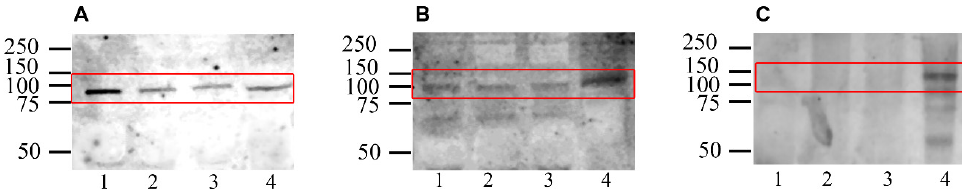
Figure 1. Western blot analysis of the presence of nitric oxide synthase isoforms eNOS ( A ), nNOS ( B ) and iNOS ( C ) in swim-up selected (lane 1) and in vitro capacitated without (control, lane 2) or with cAMP-elevating agents (Cap-C, lane 3) ram sperm protein extracts. Positive controls: rat lung extract (RLE, lane 4 in A) for eNOS, mouse brain extract (MBE, lane 4 in B) for nNOS and mouse macrophage activated with IFN ɣ /LPS lysate (LPS-L, lane 4 in C) for iNOS. Immunofluorescence analysis revealed the presence of the three isoforms in ram spermatozoa. Two different immunotypes for each isoform were distinguished. Immunotype 1 with labeling at the postacrosomal region, neck and apical edge, and immunotype 2 with labeled postacrosomal region and neck, were distinguished for eNOS (Figure 2A). Immunotype 3 with labeling at the